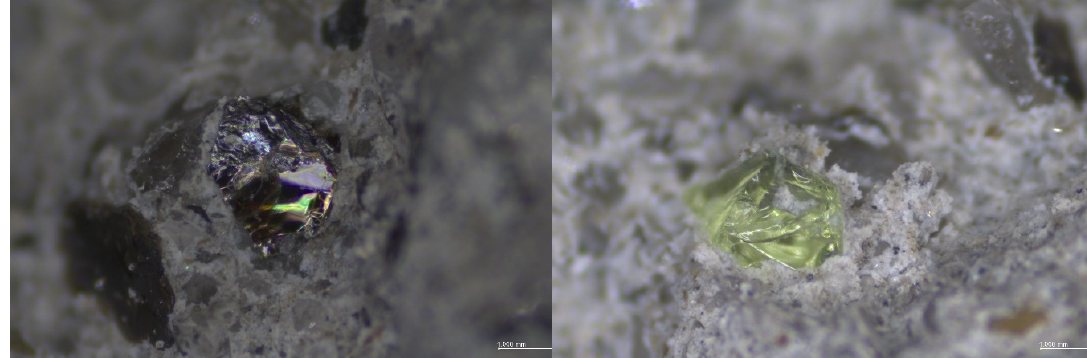
Figure 12. Light microscope images of individual glass particles of glass cullet in the cement matrix.